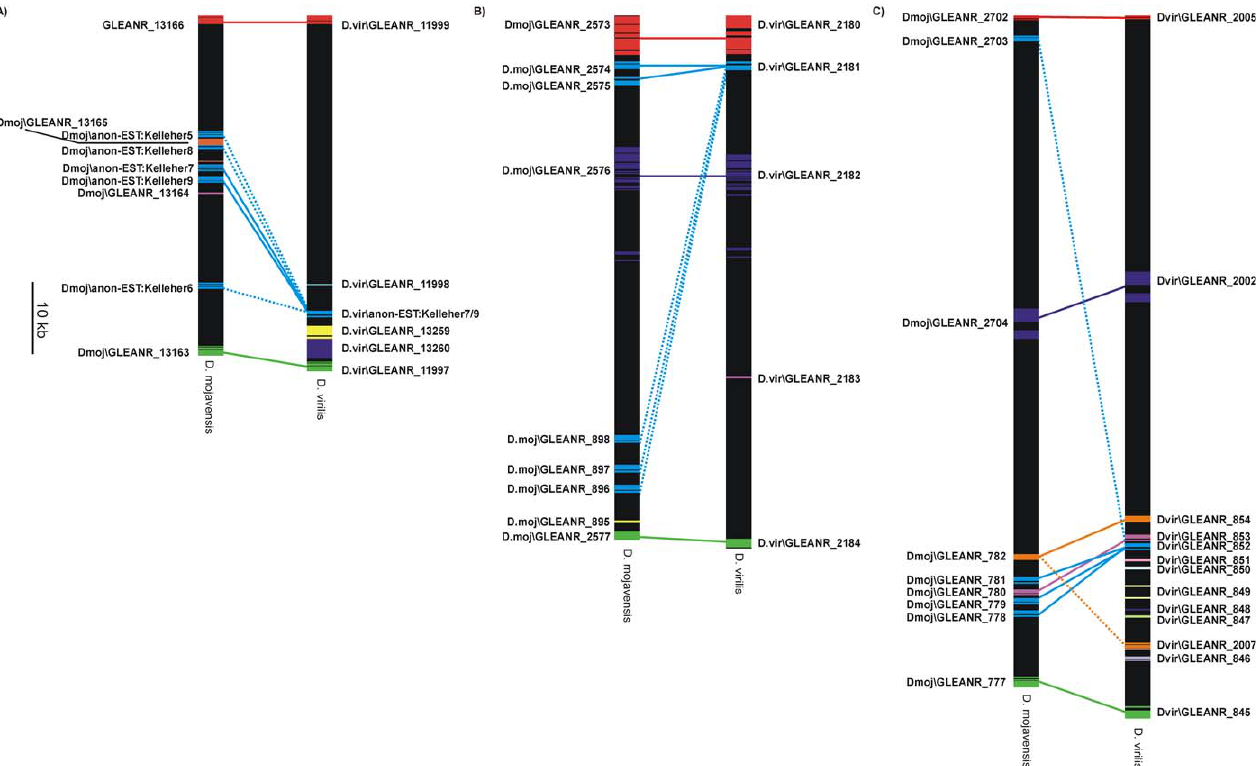
Figure 2. Distribution of Three Protease Gene Families in D. mojavensis and D. virilis Genomes (A) Syntenic regions of protease gene family 1: D. mojavensis Chromosome 4 (scaffold_6680, bp 10216565–10169309) and D. virilis Chromosome 3 (scaffold_13049, bp 10558802–10608251). (B) protease gene family 2: D. mojavensis Chromosome 3 (scaffold_6500, bp 18241557– 18296199) and D. virilis Chromosome 4 (scaffold_12963, bp 15263878–15319561). (C) protease gene family 3: D. mojavensis Chromosome 3 (scaffold_6500, bp 20970182–21063420) and D. virilis chromosome 4 (scaffold_12963 bp 12250368–12347919). Colored blocks indicate individual exons, where each gene is indicated by a different color. Orthologous genes are the same color in both species, and connected by colored lines. Solid lines indicate orthologs with the same orientation, while dotted lines indicate inverted orthologs. Multiple, tandemly duplicated copies in the genome of D. mojavensis correspond to a single gene in the genome of D. virilis. Annotation and assembly obtained from unpublished Drosophila genomes (http://rana.lbl.gov/drosophila/).